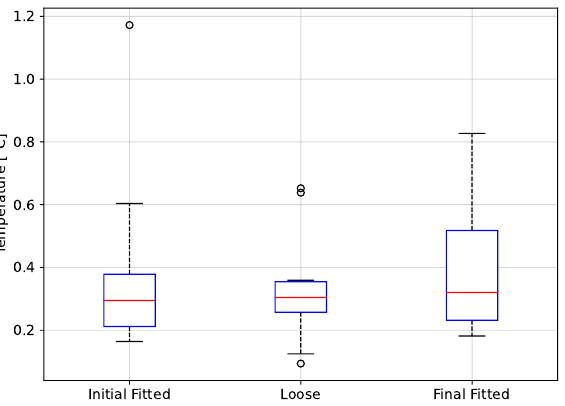
Figure 18. Peak to peak values of pressure as a function of fitting condition.